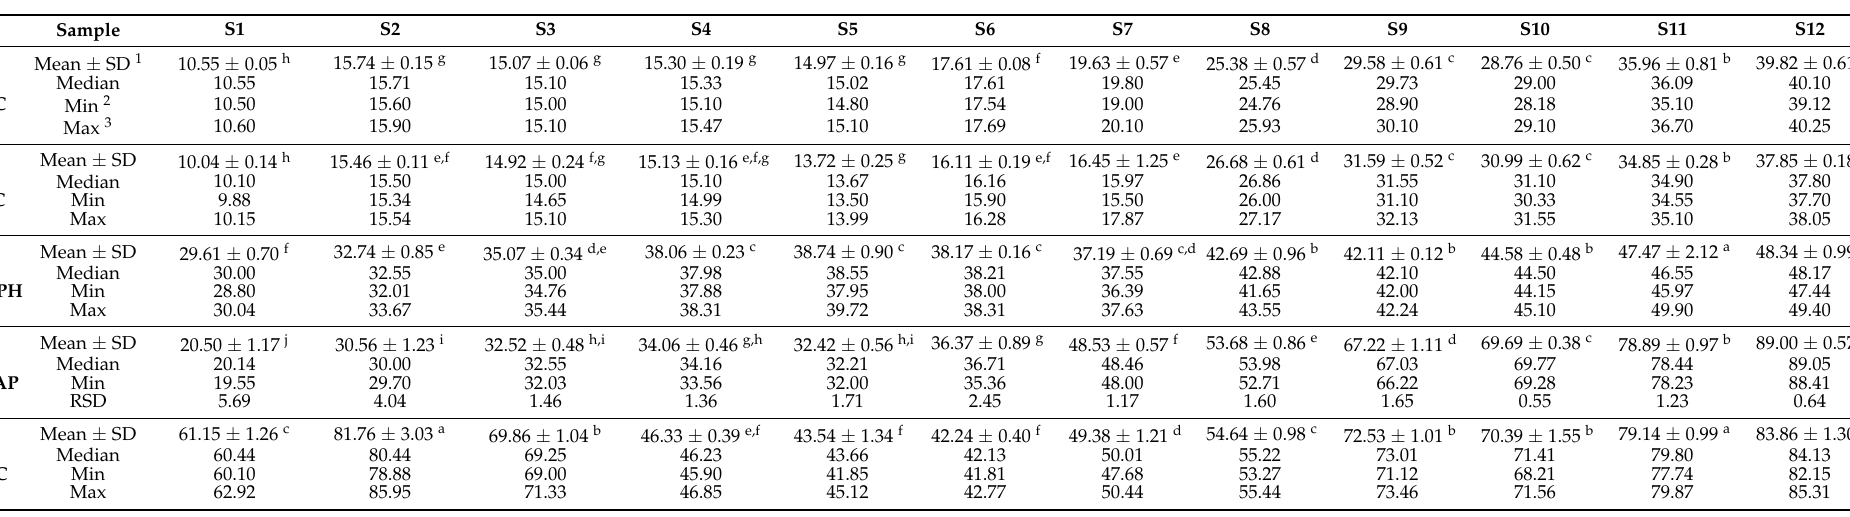
Table 1. Descriptive statistics obtained from total polyphenol and total flavonoid content and antioxidant assays of dark chocolate